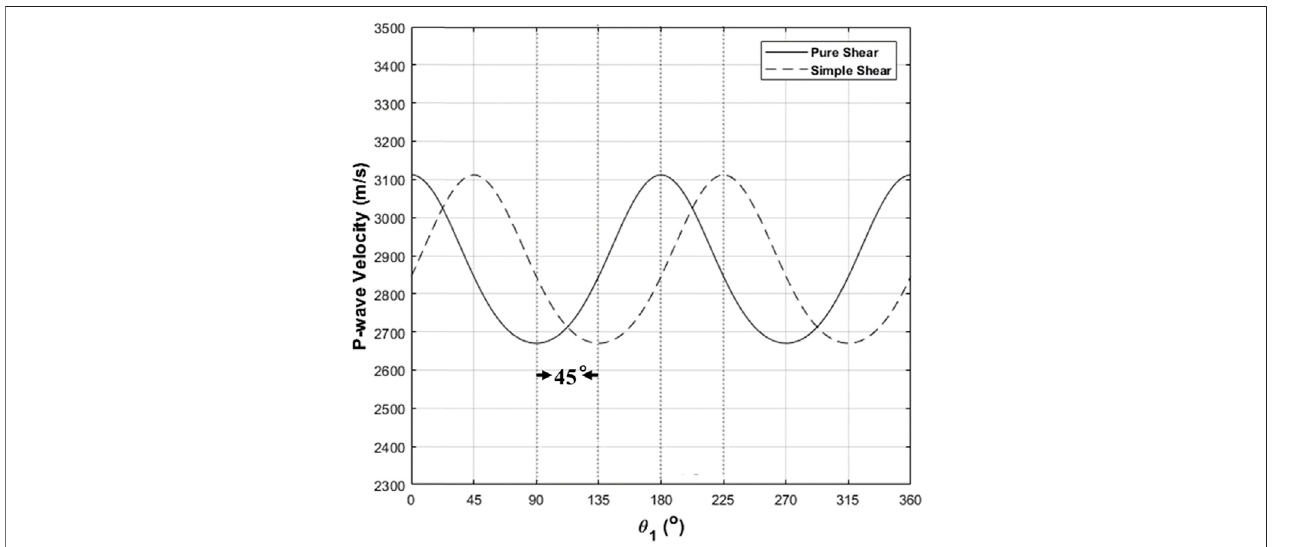
FIGURE 11 | Variations of P-wave velocity against θ 1 under the pure-shear (solid line) and simple-shear (dashed line) conditions.